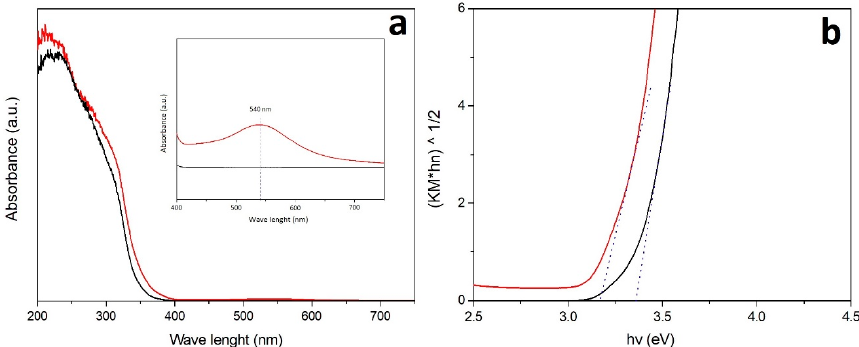
Figure 3. DR UV-Vis spectra ( a ) and corresponding Tauc plots ( b ) of P25 (black curve) and promoted with Au (0.2 wt%; red curve).